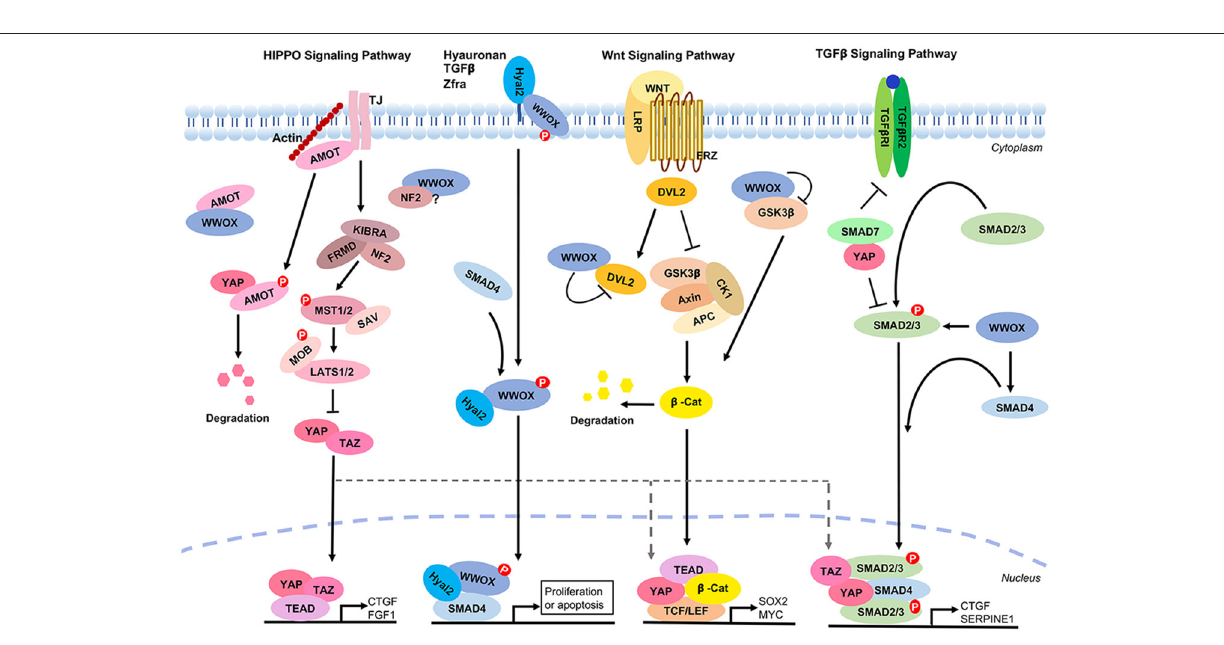
FIGURE 6 | WWOX controls TGF- β , Hyal-2, and Wnt signaling pathways that cross talks with the Hippo signaling. A panel is shown for the Hippo, Hyal-2/WWOX/Smad4, Wnt and TGF- β signaling pathways. WWOX supports the Hyal-2 and TGF- β signal pathways. However, WWOX blocks the Wnt pathway by binding GSK3 β and DvL2. WWOX binds AMOT and probably NF2 in the Hippo pathway, whereas the functional consequence of this binding is